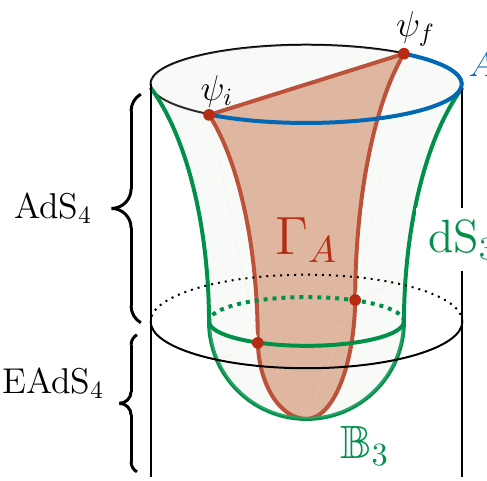
Figure 6 . A sketch of calculation of holographic entanglement entropy in the codimension-two holography. The green surface describes the dS 3 brane, where we impose the Neumann boundary condition and we expect the presence of three-dimensional gravity. The subsystem A is defined on the S 2 on the boundary of the dS 3 . The red surface describes the extremal surface Γ A whose area leads to the holographic entanglement entropy. The four-dimensional ambient spacetime is AdS 4